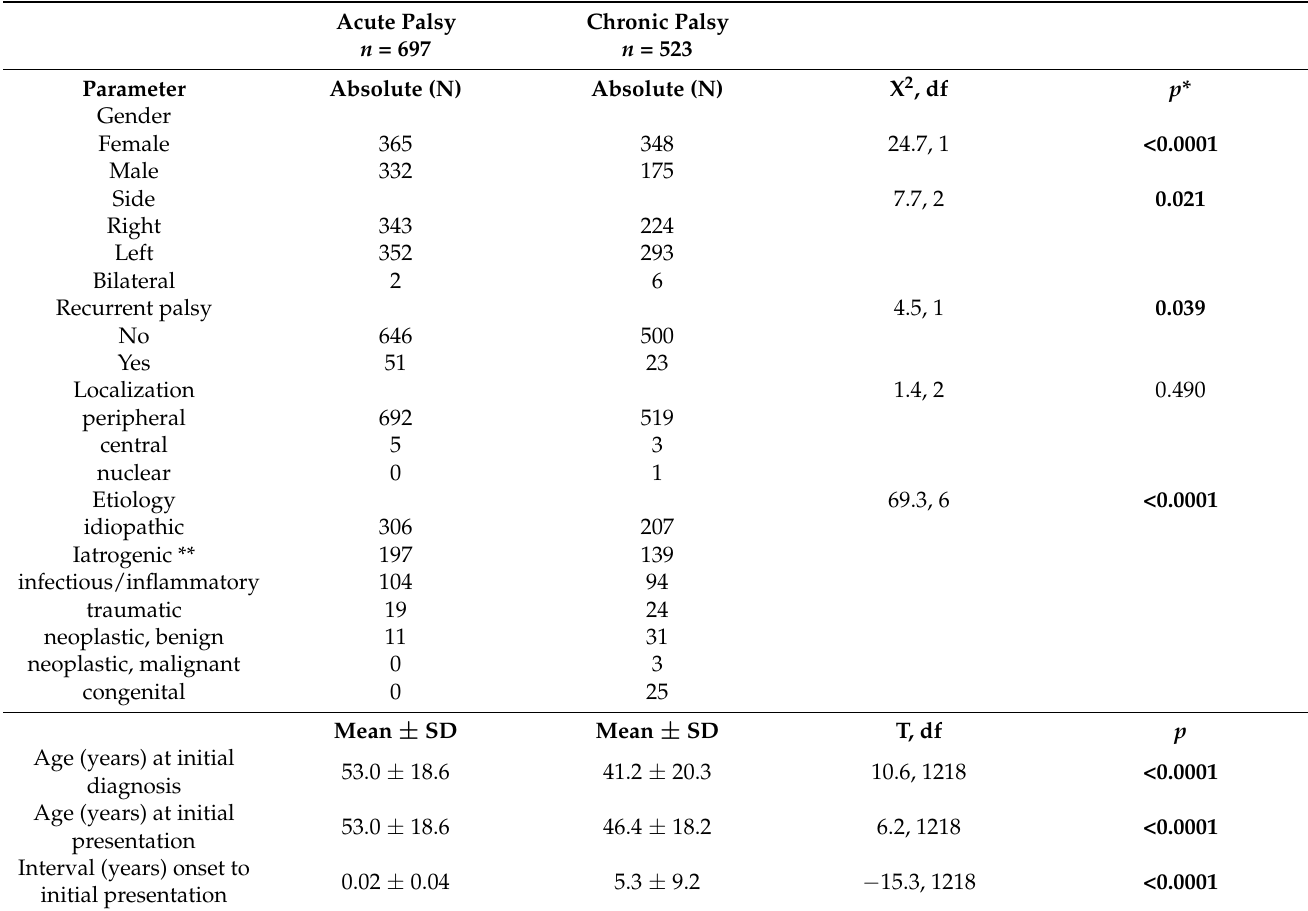
Table 1. Comparison of patients’ characteristics referred as a case of acute facial palsy ( ≤ 90 days after onset) versus as chronic facial palsy (>90 days after